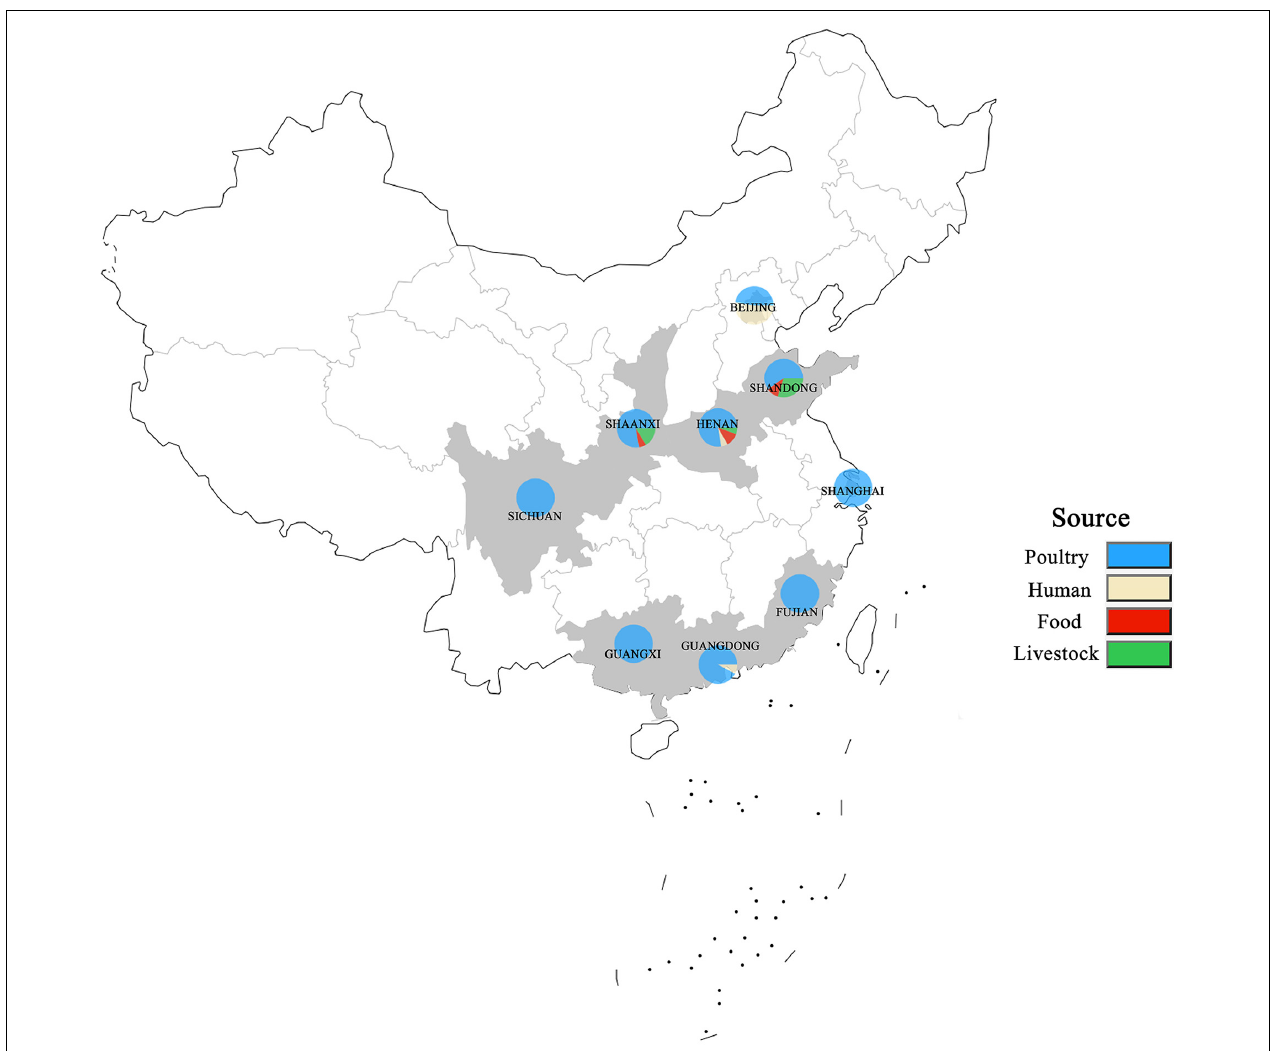
FIGURE 1 | Distribution of S. enterica isolates in China from 2004 to 2019. The locations where the strains were isolated are shown on the map. The isolates obtained from humans, poultry, livestock, and food are labeled in different